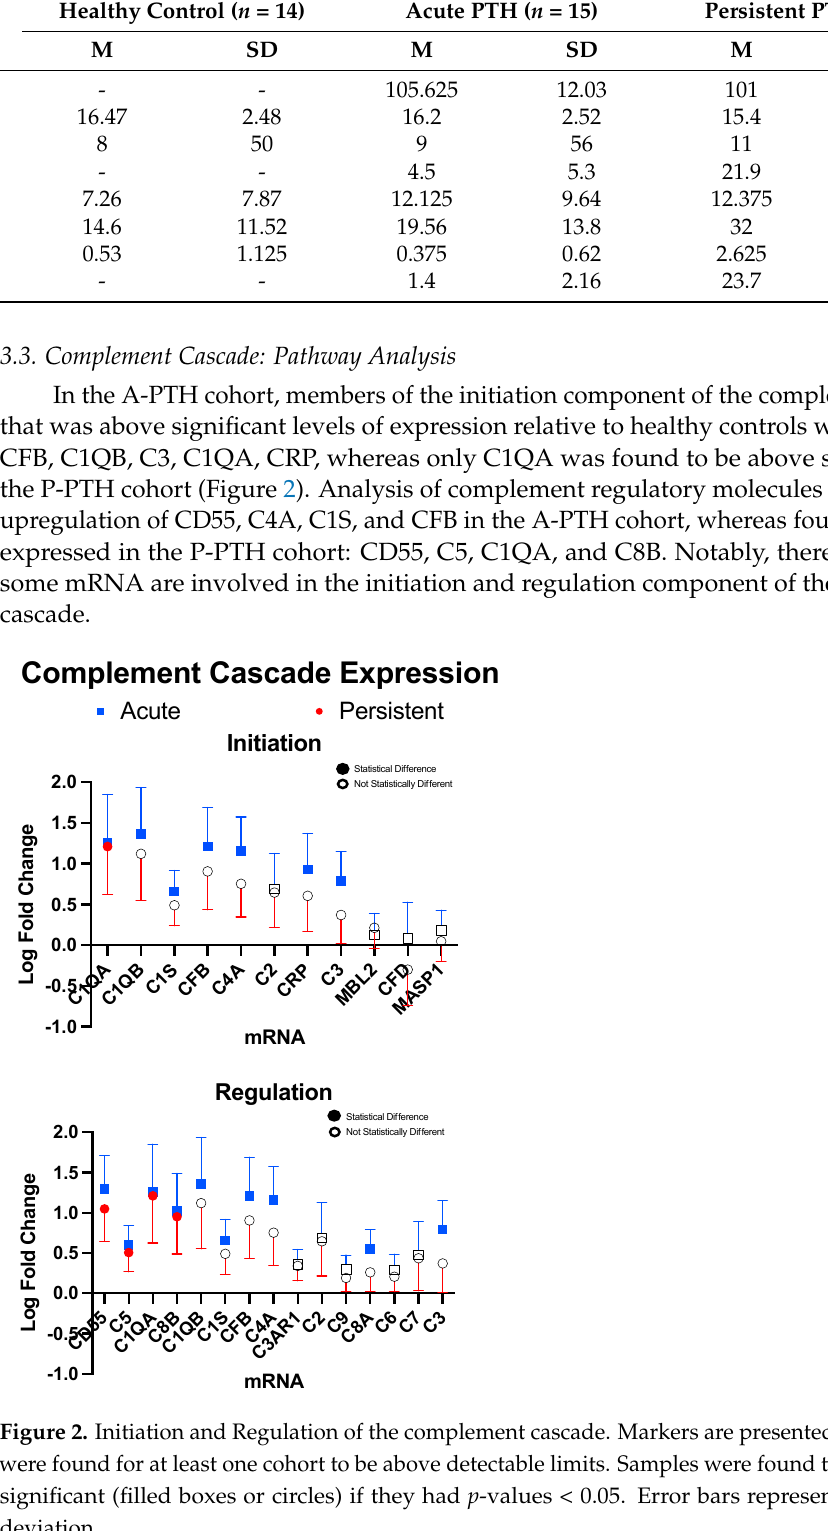
Figure 3. Summary of findings from the Principal Component Analysis. The screeplot ( left panel ), cumulative variance plot ( middle panel ), and the variance from the first two dimensions ( right panel ) with ellipses to identify the respective study cohorts are shown. 3.4. Complemented Mediated Activity Driven by Core Set of mRNA The top five candidate markers from the first component (Greater than the loading of 3) were retrieved (Figure 3 for PCA findings and Figure 4 for group outcomes). This gave five target molecules that were evaluated between PTH cohorts and healthy controls. Relative to healthy controls, the A-PTH cohort had greater expression of C1QA, t(26) =